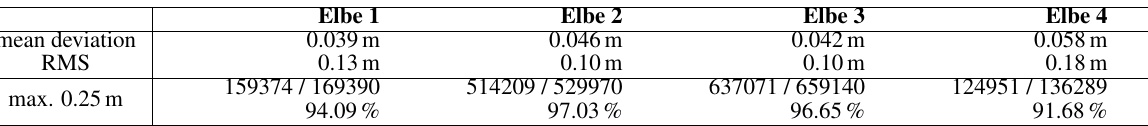
Table 1. Line 1-2 show the mean deviation value and the RMS -deviation of the height component between new recognized points and the comparative data. Line 3-4 present the number of points with a max. height-deviation of 0.25 m related to the number of all recognized points and the percentage.